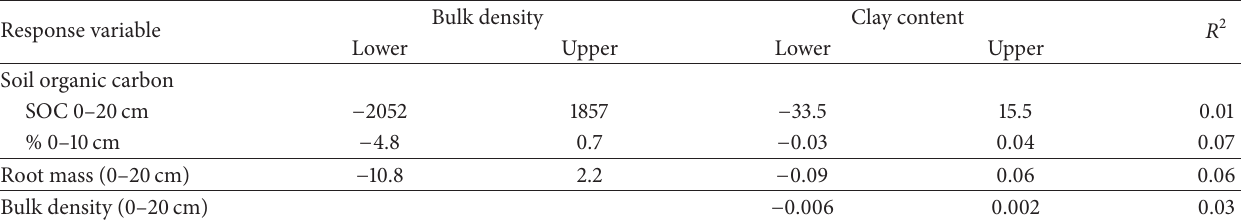
Table 4: Results of four multiple linear mixed effect regression models each comparing response variables against bulk density and clay content as independent variables (fixed effects). Lower and upper bounds define simulated 95% confidence intervals while 𝑅 2 reports goodness-of-fit for multiple fixed